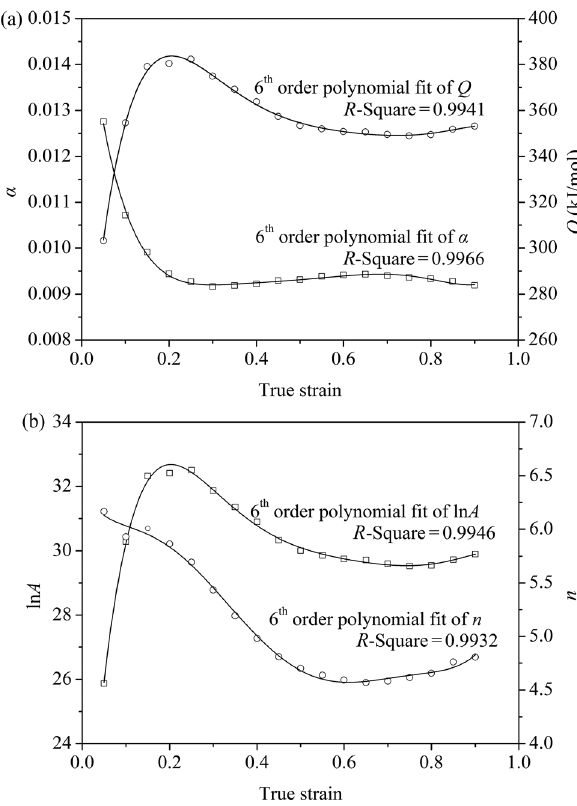
Figure 10: The influence law of strain on material parameters.